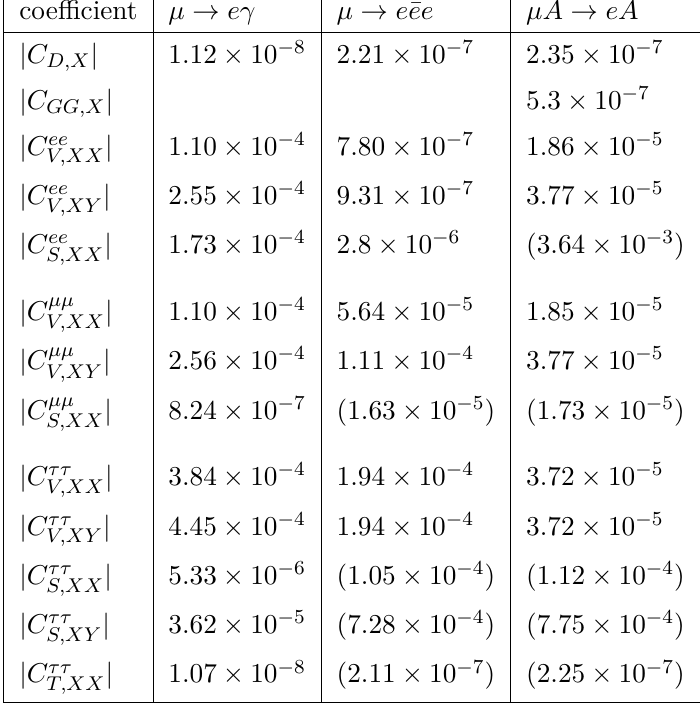
Table 3 . Current sensitivities of the processes in the first row to the coefficients, at m W , of QCD × QED-invariant 2- and 4-lepton operators defined in section 2.1. X, Y ∈ { L, R } , X 6 = Y